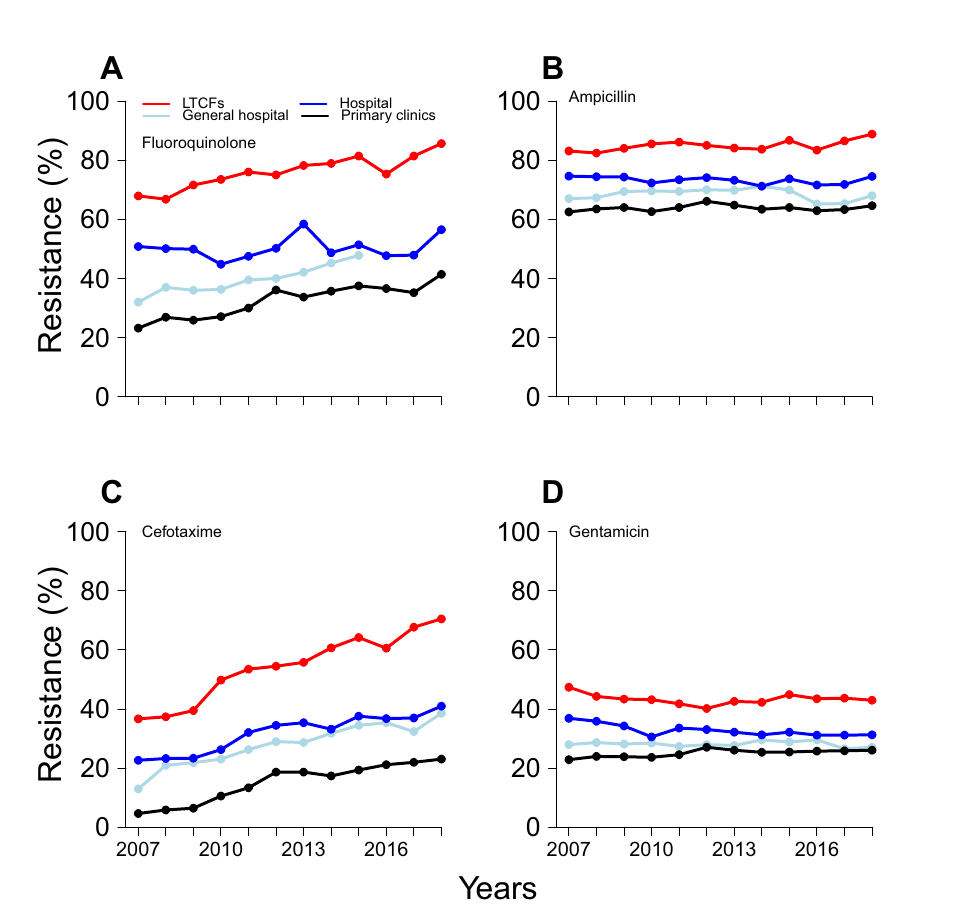
Figure 2. Resistance rate of Escherichia coli to antibiotics, including ( A ) fluoroquinolone, ( B ) ampicillin, ( C ) cefotaxime and ( D ) gentamicin, in South Korea between 2007 and 2018. The red line indicates long-term care facilities (LTCFs), and the blue line indicates hospitals. The white-blue line indicates general hospitals, and the black line indicates primary